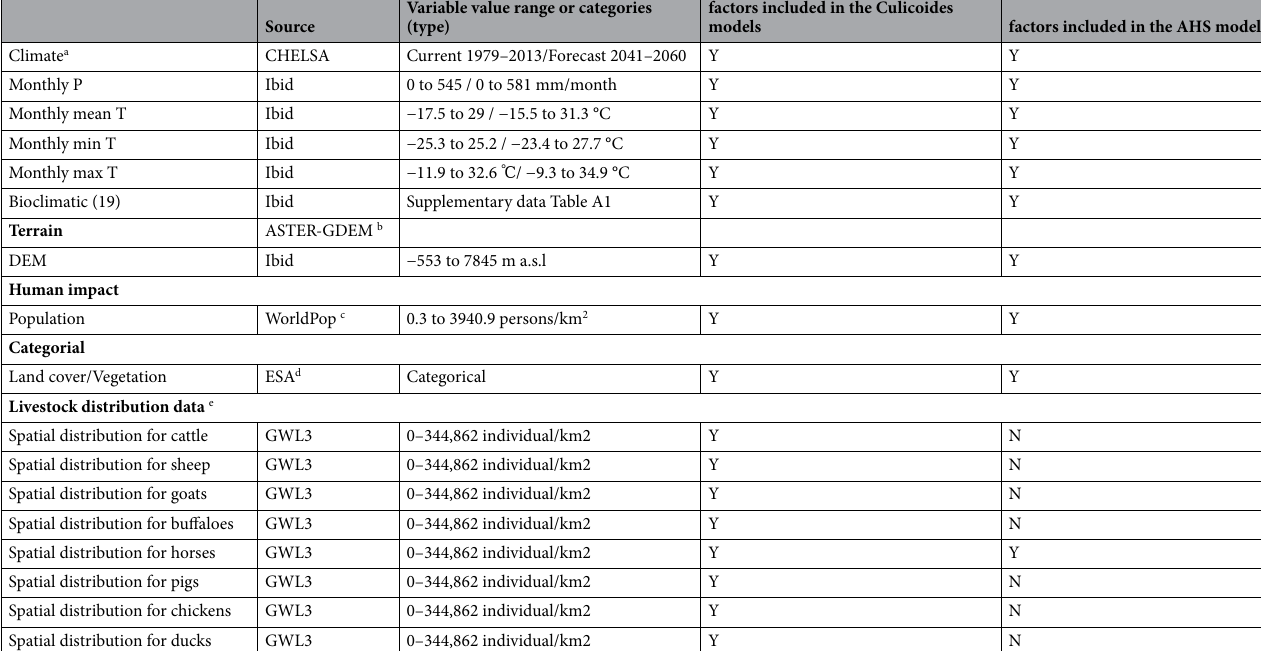
Table 1. Data layer and source, raster/vector, value range/categories and specification of the unit of measurement/impact (proxy) included in the models. a T = temperature; P = precipitation. Source: http:// chelsa- clima te. org/. b Source: http:// www. gsclo ud. cn/. c Source: https:// www. world pop. org/. d Land cover: Cropland, Herbaceous, Tree, Shrubland, Grassland, Urban areas, Bare areas, Water bodies and Permanent snow and ice. e Source: http:// www. fao. org/ lives tock- syste